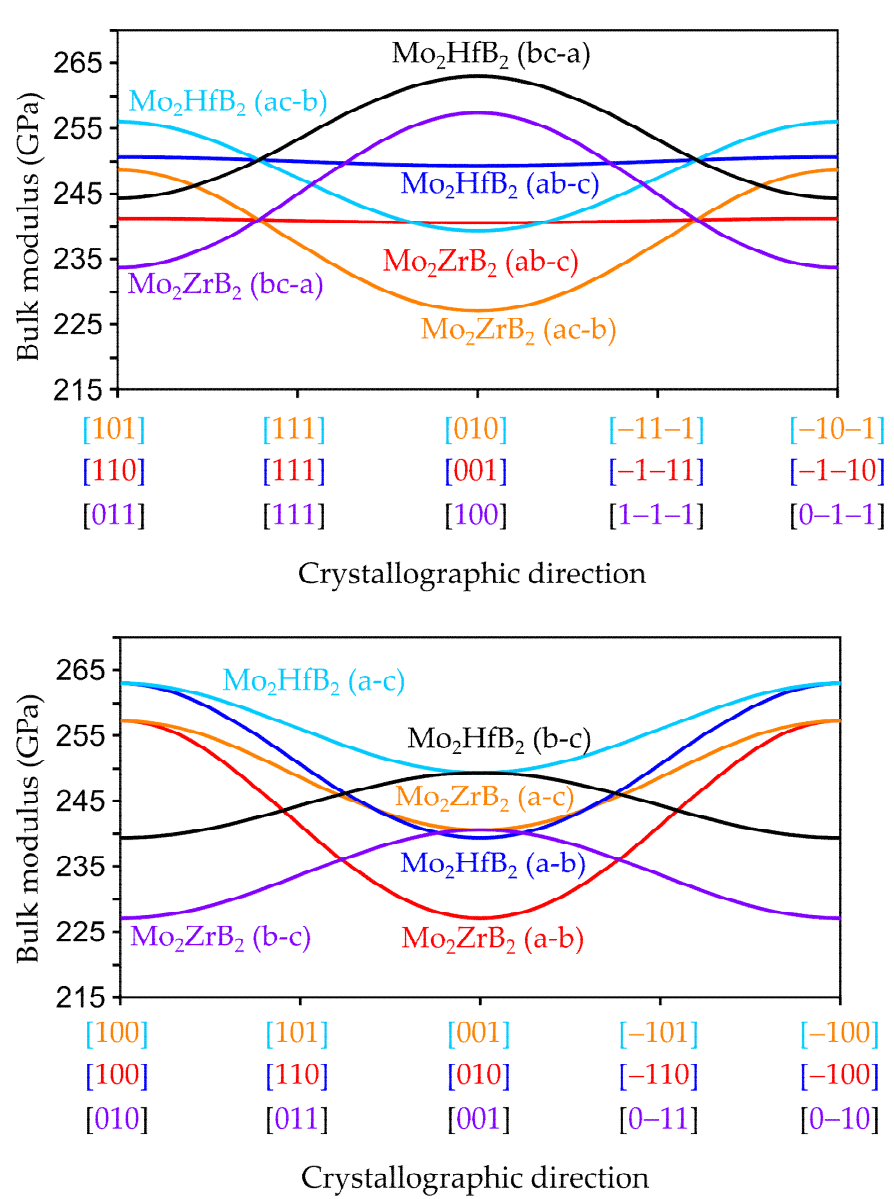
Figure 4. Anisotropic bulk modulus in the a - b , a - c and b - c -plane ( lower part ) and the ab - c , ac - b and bc - a -plane ( upper part ) of Mo 2 ZrB 2 (red, orange and purple) and Mo 2 HfB 2 (blue, cyan and black), respectively, both with the AlMn 2 B 2 -type structure.